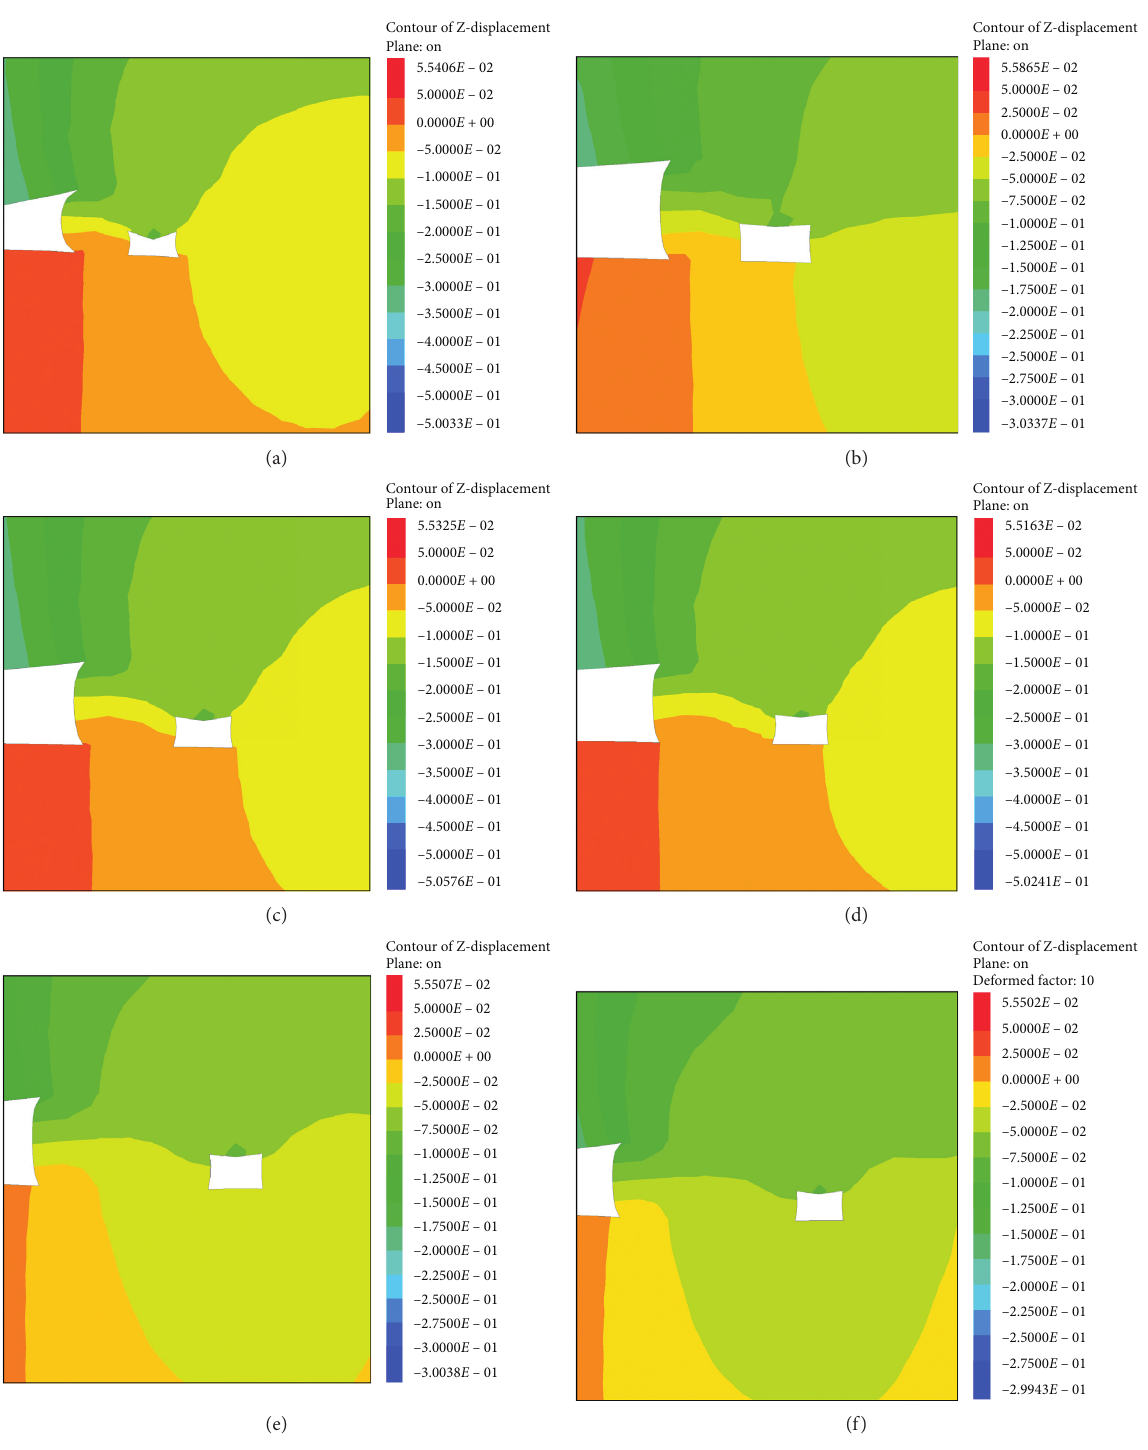
Figure 18: Vertical displacement of coal pillar in different width sections: (a) 4m, (b) 5m, (c) 8m, (d) 10m, (e) 13m, and (f)